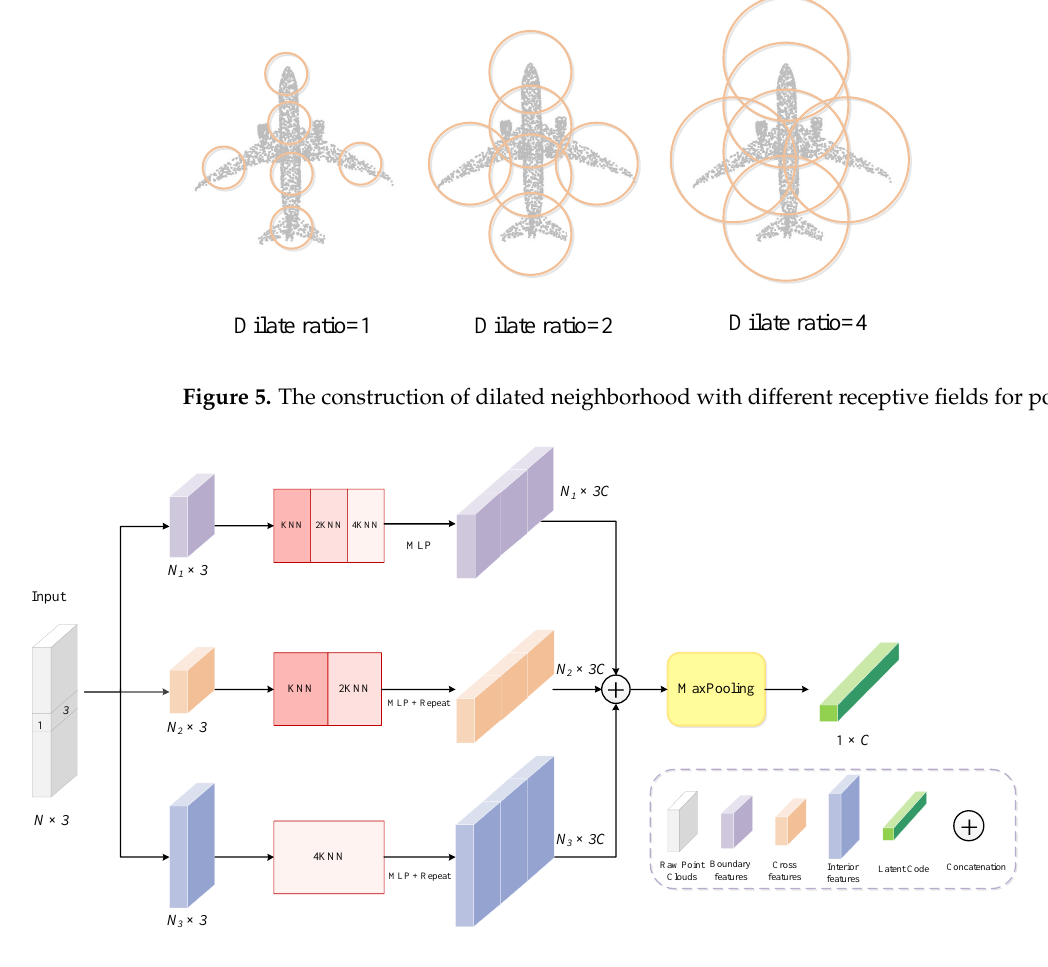
Figure 6. The architecture of the proposed dynamic feature aggregation (DFA) module. Note that KNN denotes the dilated ratio is 1, 2KNN denotes the dilated ratio is 2, and 4KNN denotes the dilated ratio is 4. N 1 , N 2 , and N 3 denote the number of boundary points, cross points, and interior points, respectively, and N 1 + N 2 + N 3 = N